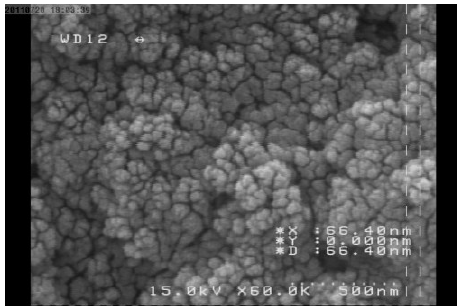
Figure 1. SEM image of synthesized nano-Fe